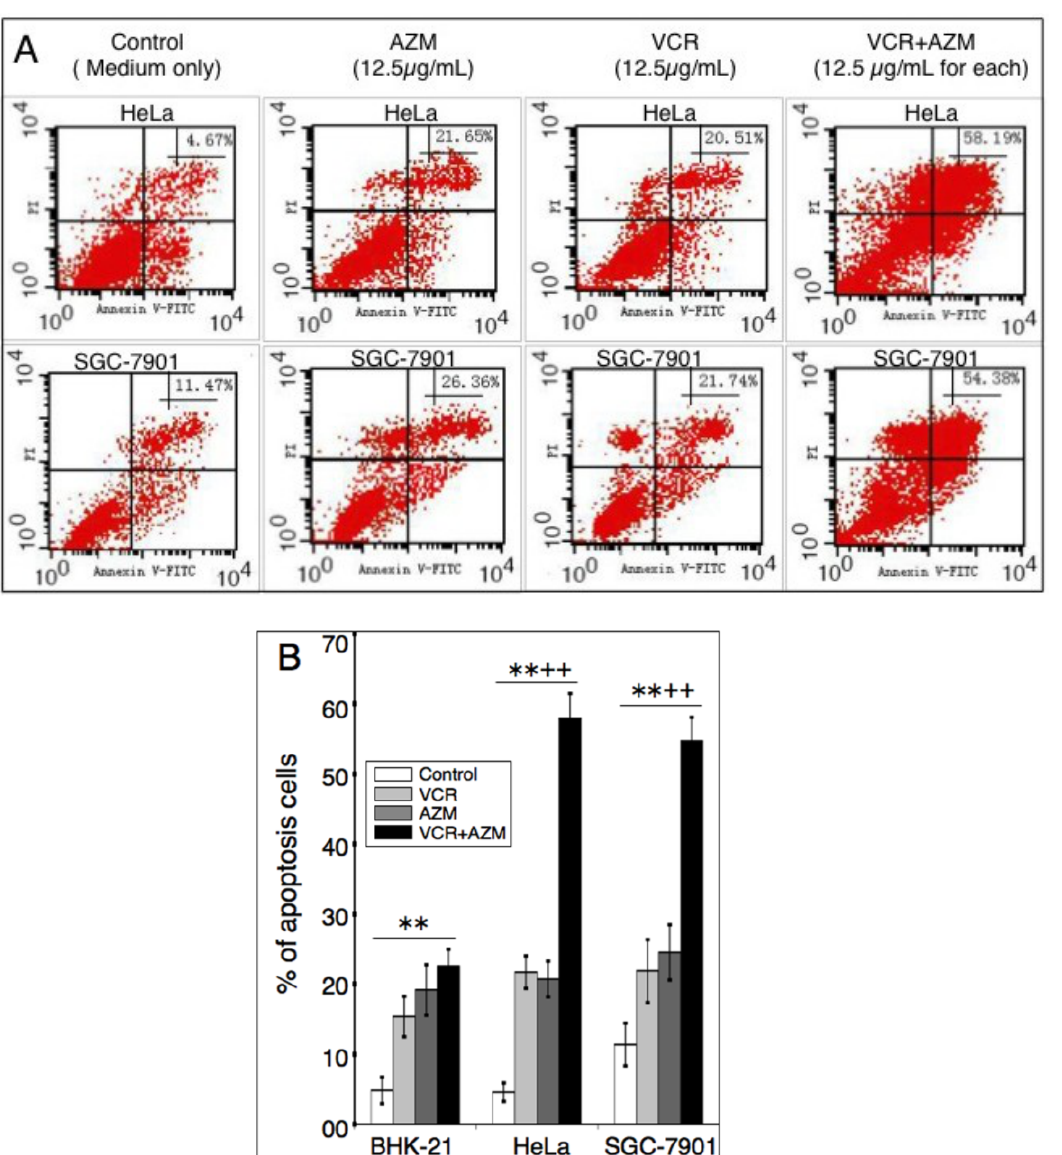
Figure 3. Apoptosis determined by annexin V binding assay and flow cytometry analysis. Indicated cells were treated with 12.5 µg/mL of each AZM or VCR alone, or a combination of the two agents for 48 h, and then stained with annexin V, followed by cytometry analysis. ( A ) A representative profile of Annexin-V-FITC/PI staining of Hela cells (top panel) and SGC-7901 cells treated with indicated agents for 48 h. The bottom left quadrant shows the viable cells, neither binding annexin V nor showing PI uptake; the bottom right quadrant represents the early apototic cells, binding annexin V but still retaining their cytoplasmic integrity and excluding PI; the top left quadrant shows nonviable necrotic cells/nuclear fragments with no annexin V binding but PI uptake; the top right quadrant represents nonviable, late apoptotic/necrotic cells, positive for annexin V and PI staining, the percentage of cells falling within this corner was indicated. ( B ) Statistical analysis of results of nine samples. Data represent the mean (±SD) from three independent experiments for each condition (N = 9). Compared with medium